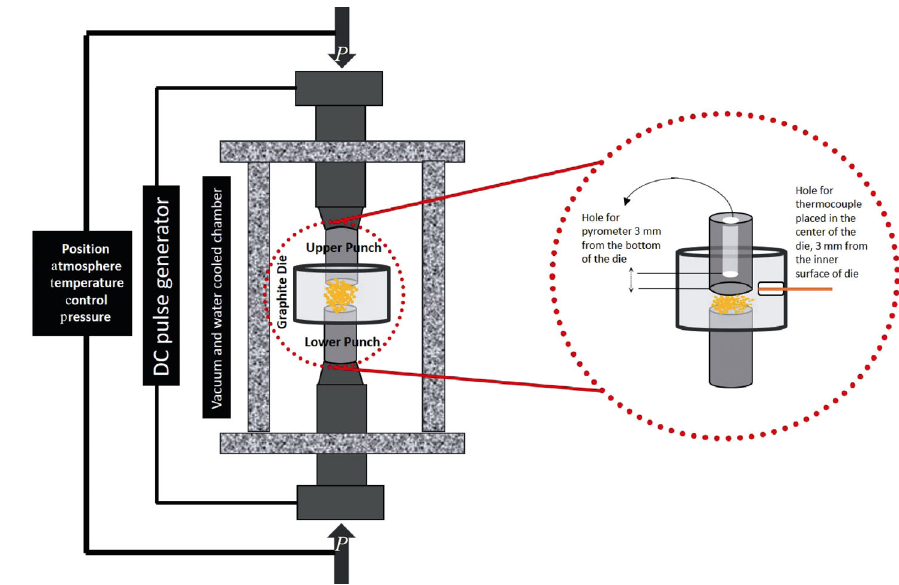
Fig. 2 Schematic of SPS equipment showing the die and temperature measurement